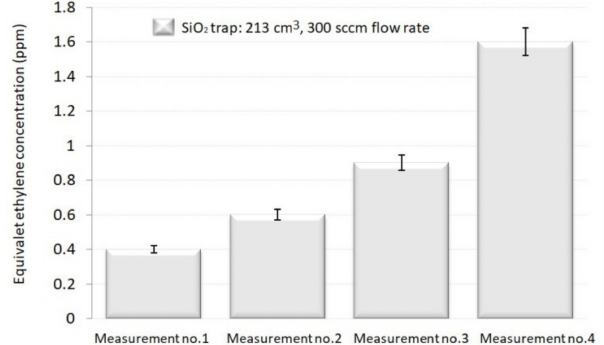
Figure 6. Decrease of SiO 2 traps capacity when the identical replenish was used for multiple tests.